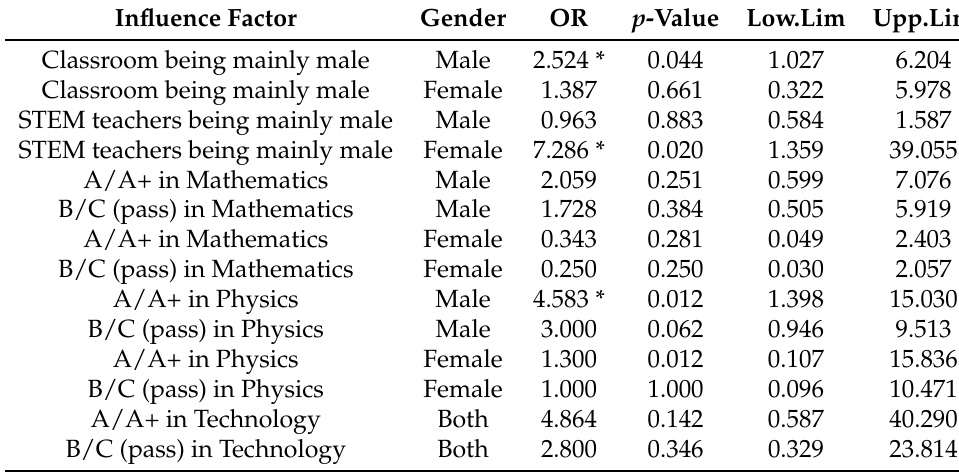
Table 4. Odds ratios, p -values and 95% confidence intervals obtained for the study of the advantage for the decision of studying an engineering depending on influence factors for both male and female students. An * indicates statistical significance at level